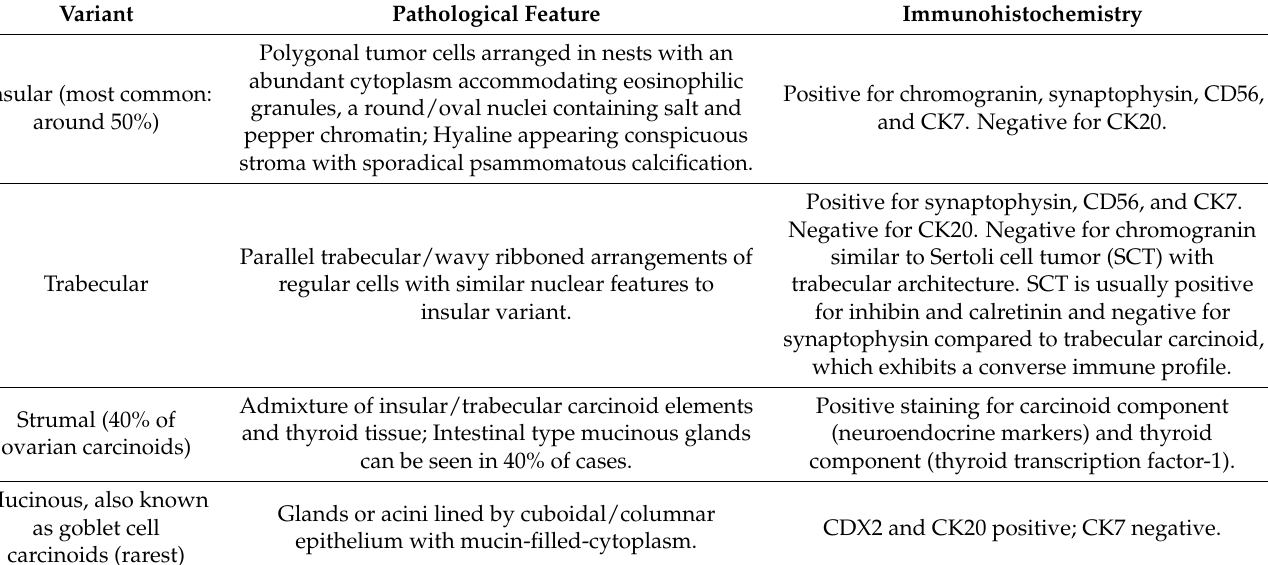
Table 7. Variants of ovarian carcinoid tumors and their pathological and immunohistochemical features.